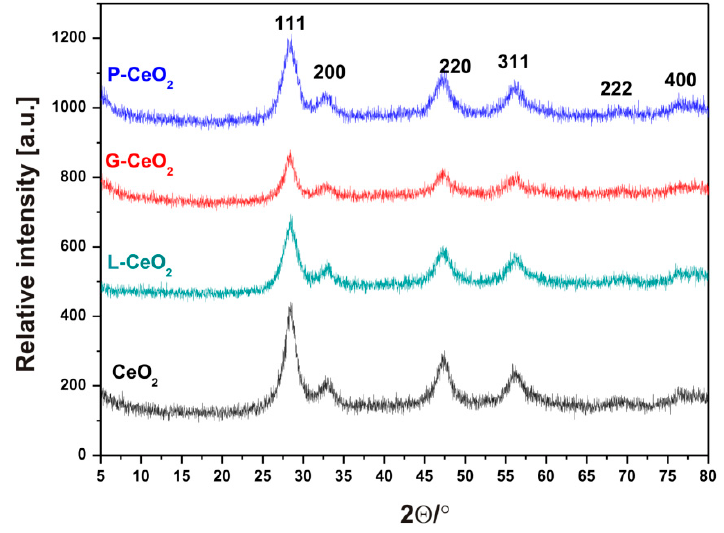
Figure 2. X-ray diffraction ( XRD) patterns of the uncoated and three different coated nCeO 2.